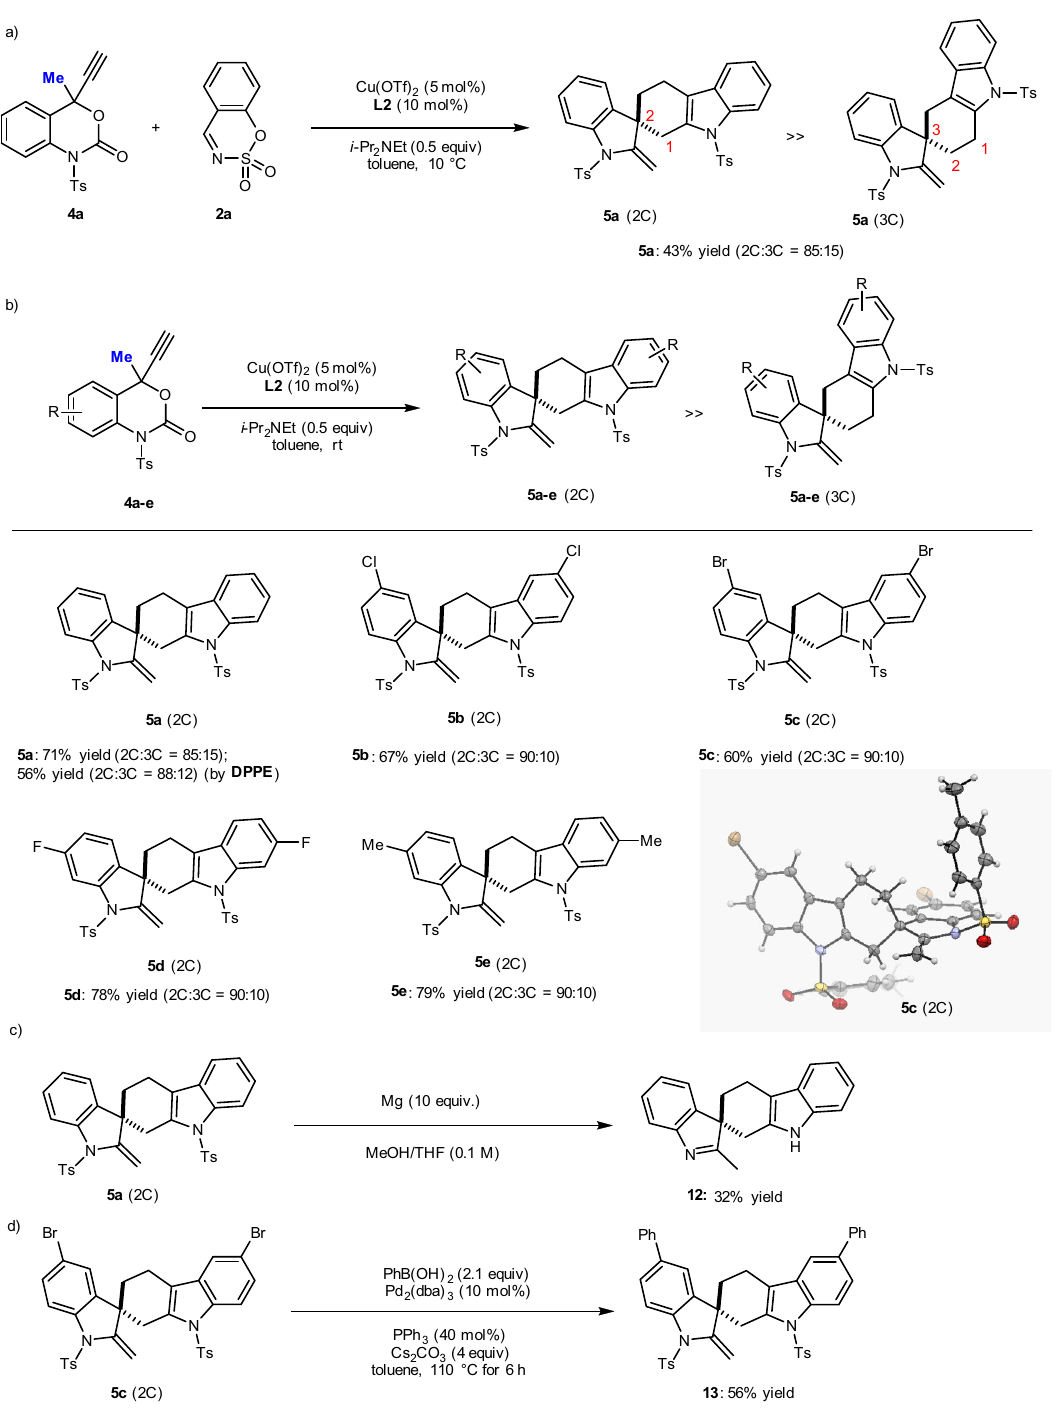
Fig. 6 Cu-catalyzed decarboxylative annulation of CH 3 -benzoxazinanones 4. a Reaction of 4a with 2a under Cu-catalysis. b Substrate scope for the Cu- catalyzed decarboxylative formation of spiral carbazole/indoline derivatives 5 from 4 . c Detosylation of 5a . d Suzuki − Miyaura coupling reaction of 5c (2C) with PhB(OH) 2